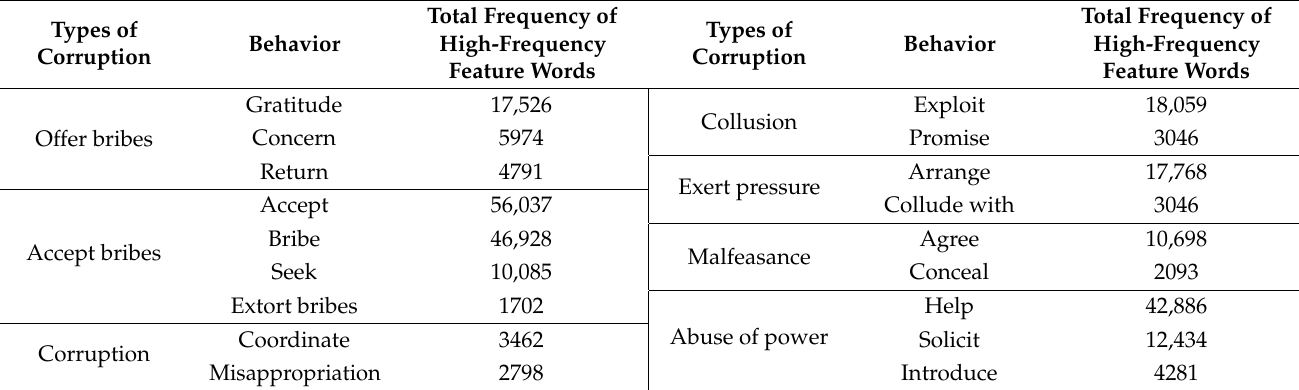
Table 3. Bidding corruption types and ways they correspond.